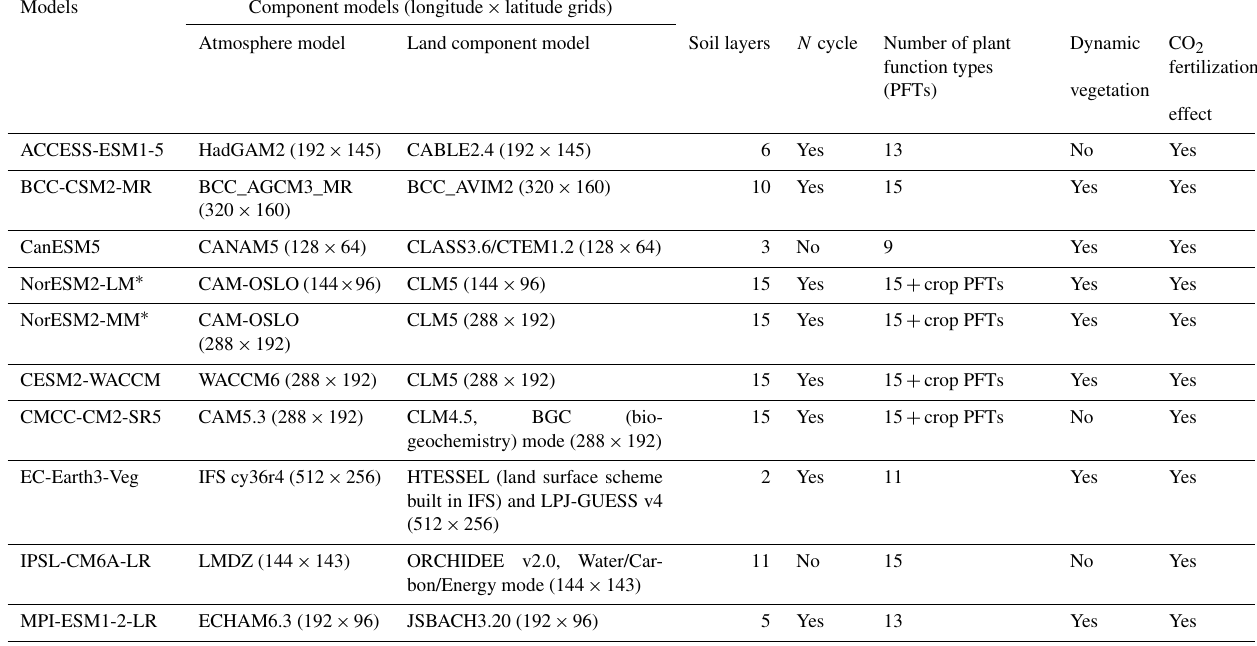
Table 1. The CMIP6 models analyzed in this study, the model land and atmosphere components, spatial resolutions, and key relevant model features are